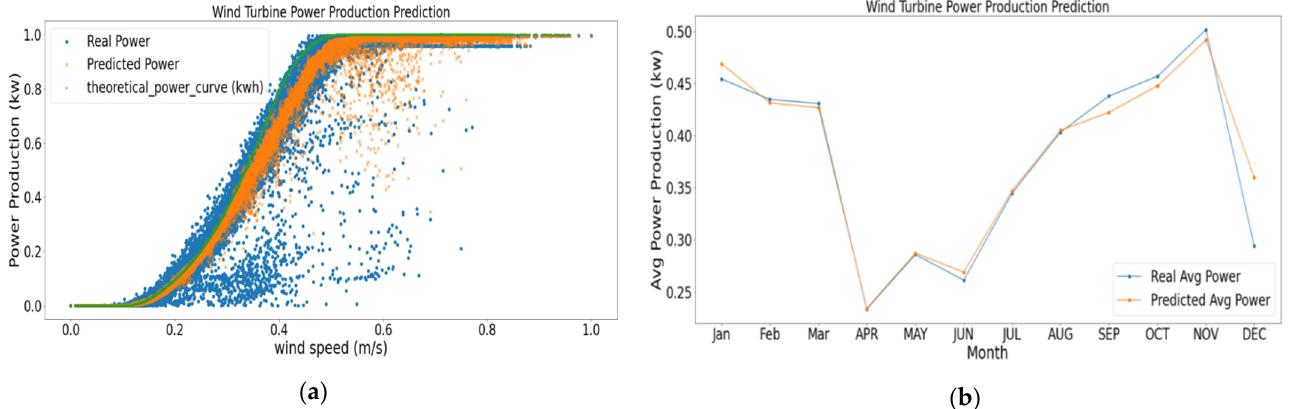
Figure 15. ( a ) Scatter plot depicting the relationship between the wind speed (m/s) and the power production (kW) of the turbine when using extra tree regression. ( b ) Predicted average power in comparison with real average power of the turbine (kW) when using extra tree regression.